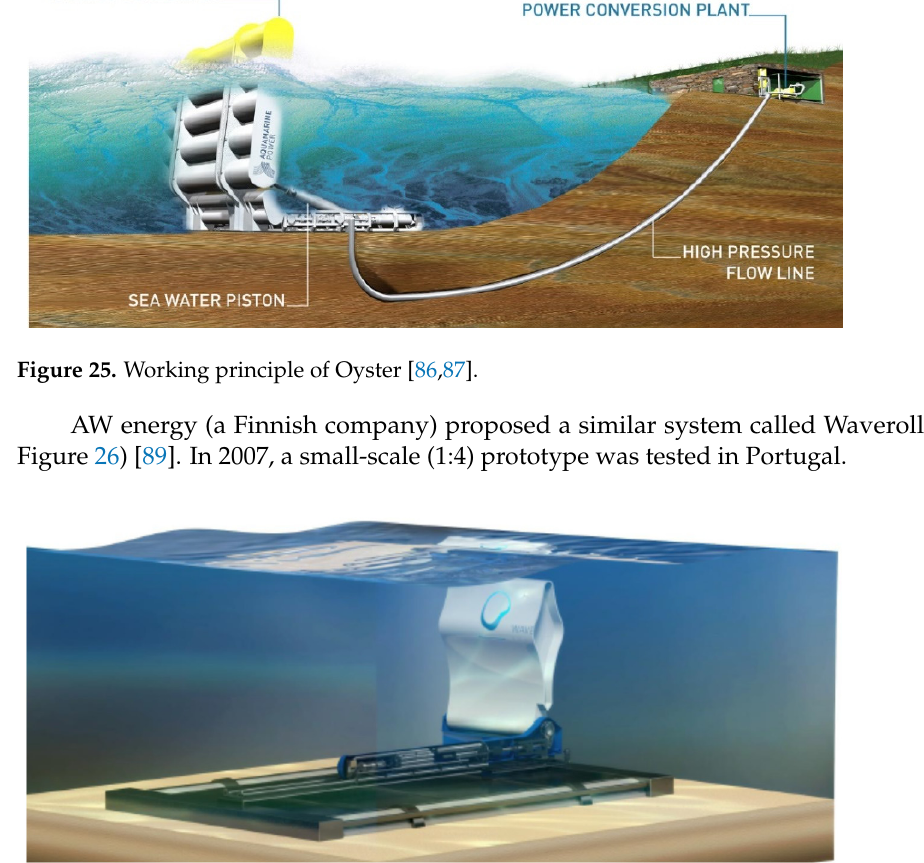
Figure 26. Rendering view of Waveroller [89].